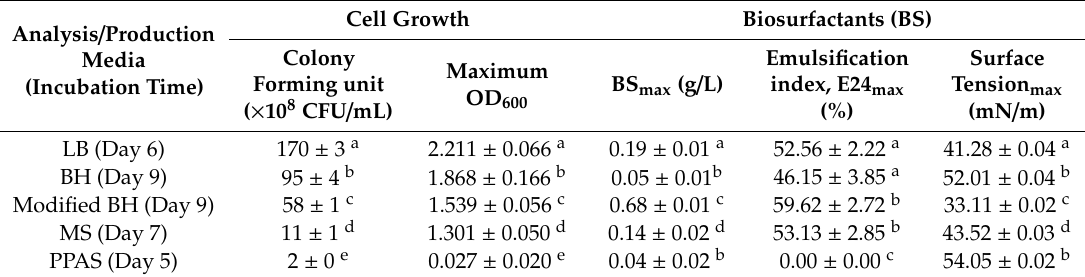
Table 2. E ff ect of di ff erent production media used towards cell growth and biosurfactants production by Pseudomonas sp.